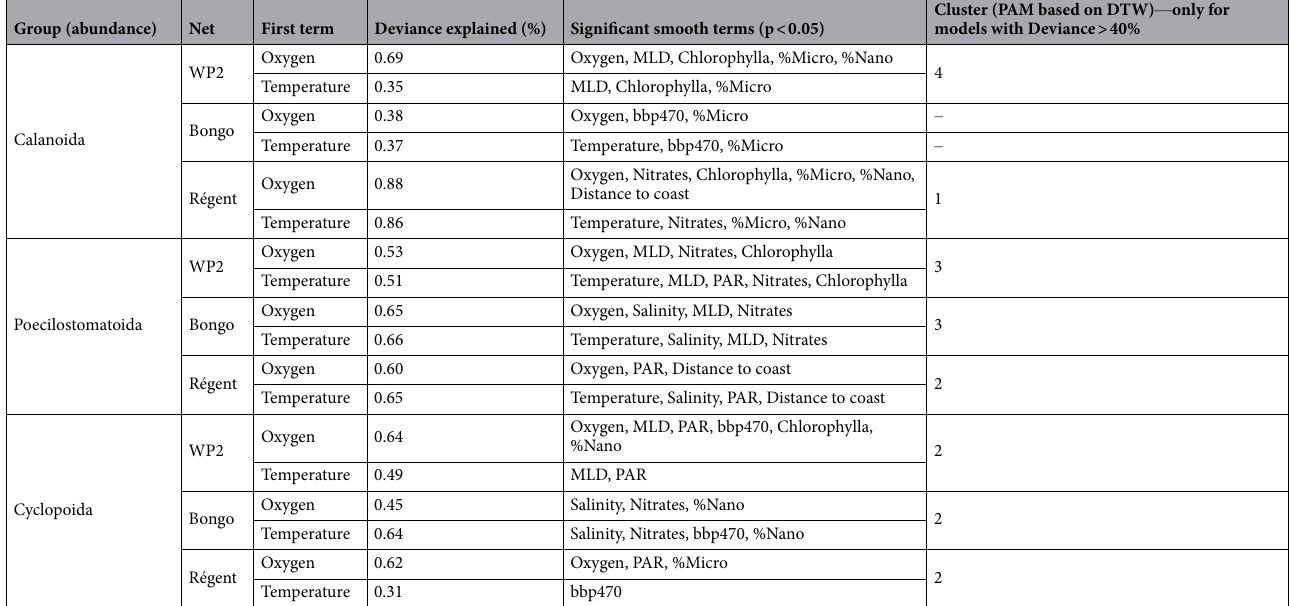
Table 2. Summary of the explanatory power (i.e. % of deviance explained) of the Generalized Additive Models (GAMs) fit to model the global gradients cubic-transformed abundance (ind m 3 ) as a function of the ten environmental covariates selected, measured for the zooplankton groups and for the plankton nets that sampled enough stations (> 30) and enough individuals (> 20) per group. The significant covariates (p < 0.05) were ranked based on their relative F statistic and are shown. The GAMs displaying a % of deviance explained > 40% were clustered into five groups based on the shape of the smoothing curves of each covariate (Fig.